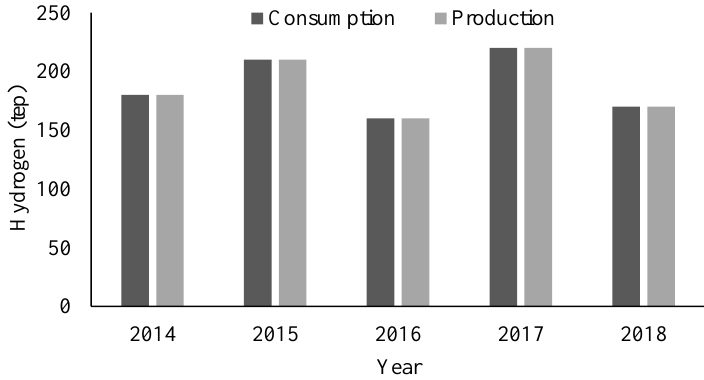
Figure 4. Evolution of hydrogen production and consumption in Portugal